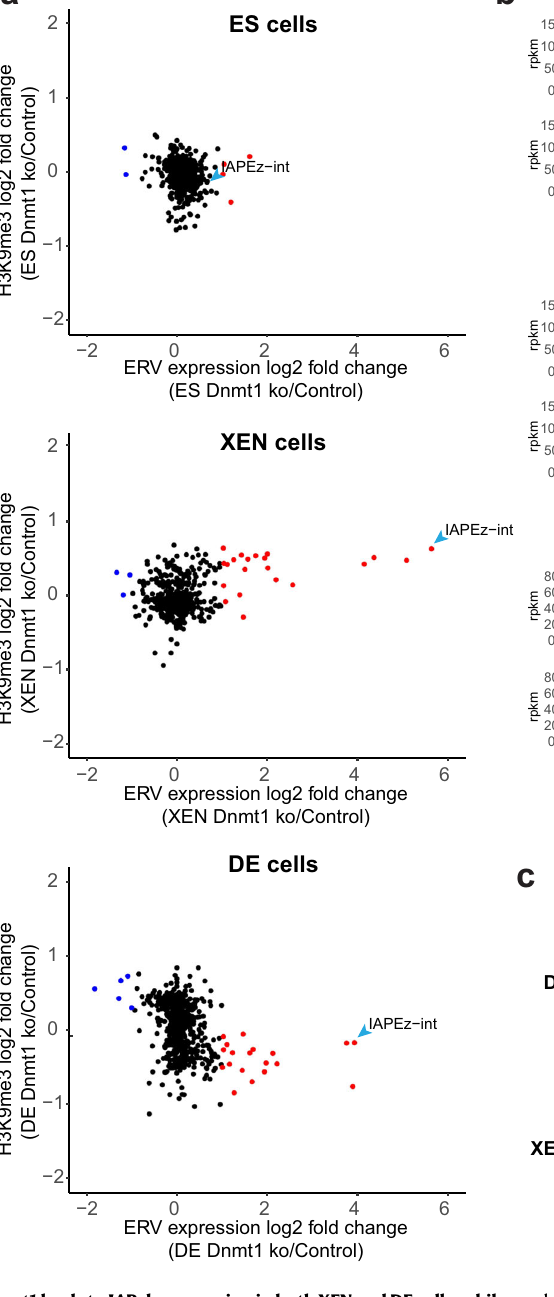
elements is shown schematically. (rpkm=reads per kilobase per million of reads). c Improper transcriptional termination allows identi fi cation of